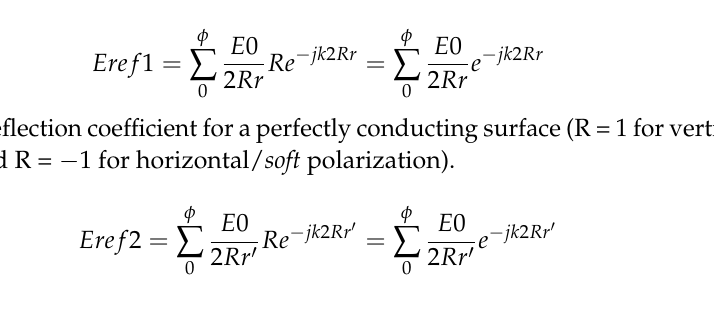
Figure 14. Reflected rays over the second obstacle (Eref2) of the considered LOS scenario.